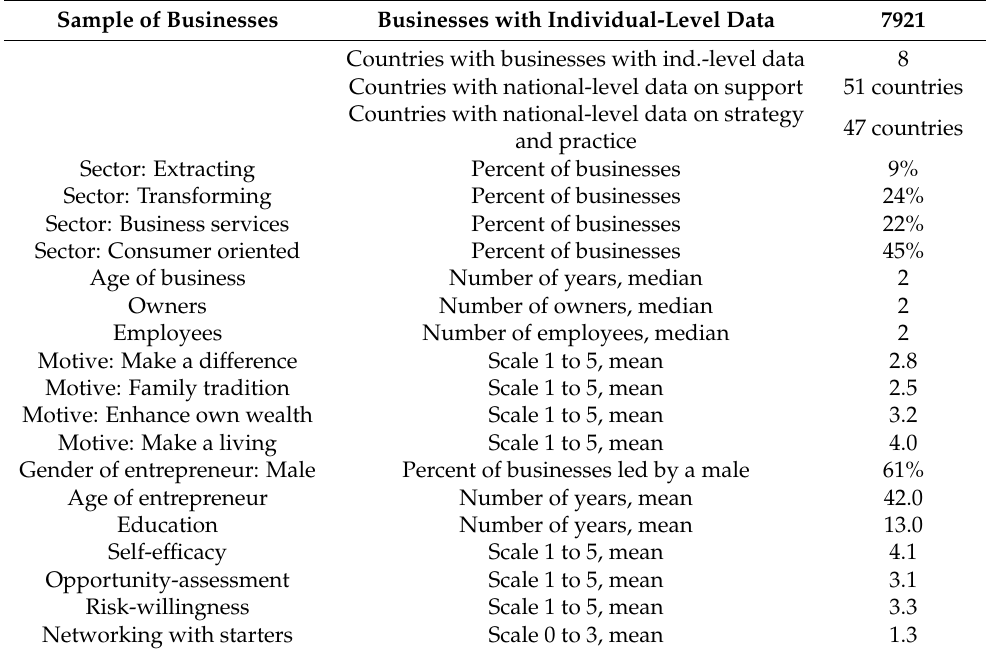
Table 1. Characteristics of businesses and entrepreneurs; in MENA and Spain. Sample of Businesses Businesses with Individual-Level Data 7921 Countries with businesses with ind.-level data 8 Countries with national-level data on support 51 countries Countries with national-level data on strategy and practice